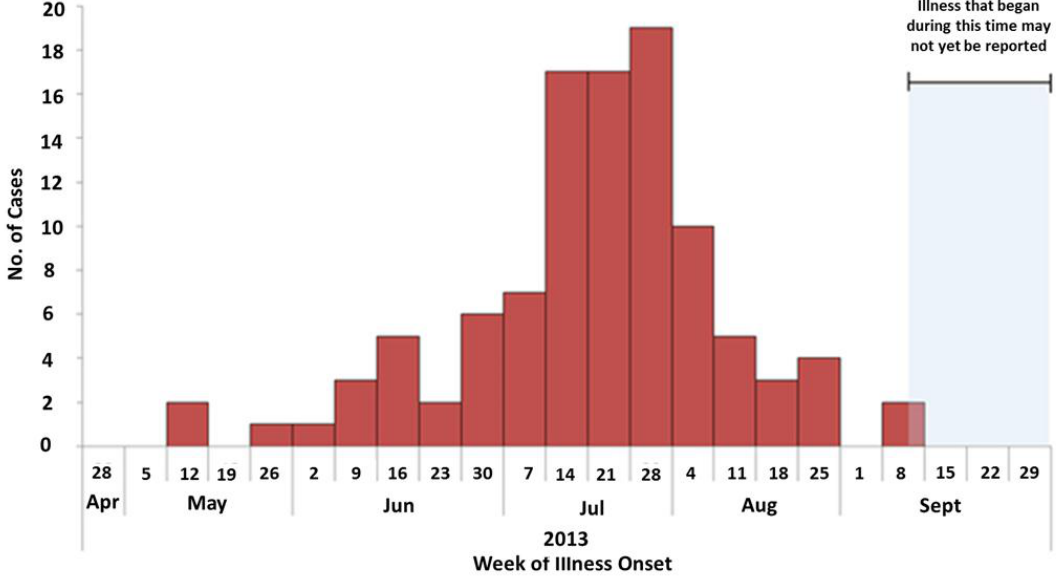
Figure 1. Number of Vibrio parahaemolyticus illnesses by week of illness onset [33].